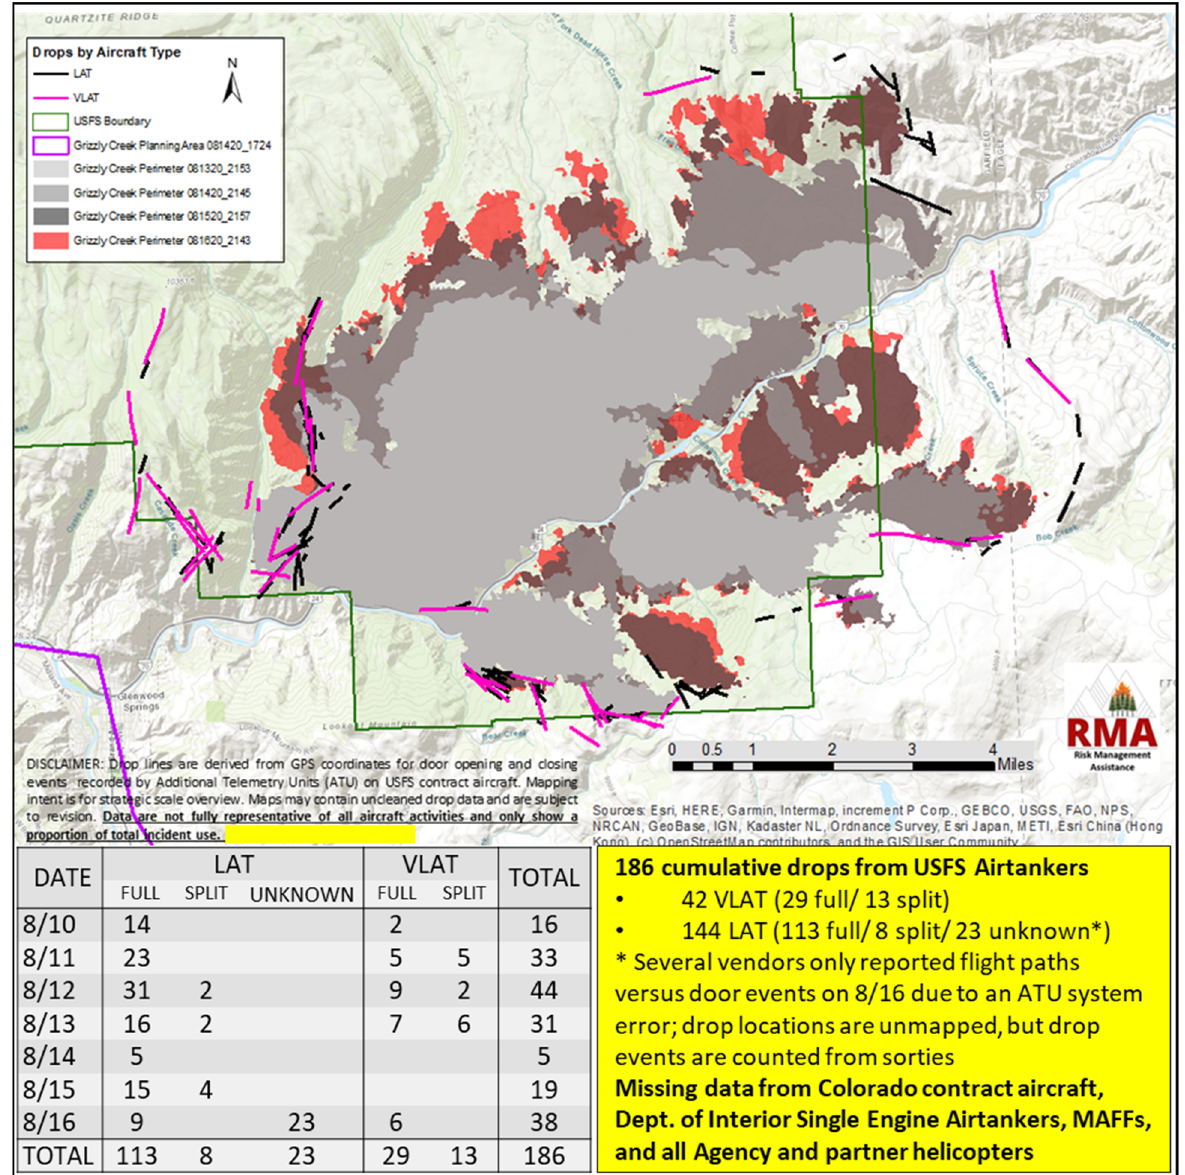
Figure 5. Example AUS drop overview map with narrative drop summary and supporting drop count table: Grizzly Creek Fire, Colorado, USA, 8/10/20-8/16/20. LAT—large airtanker; VLAT—very large airtanker; USFS—United States Forest Service; MAFFS—Modular Airborne Firefighting System; Full—full load drop event; Split—split load drop event.